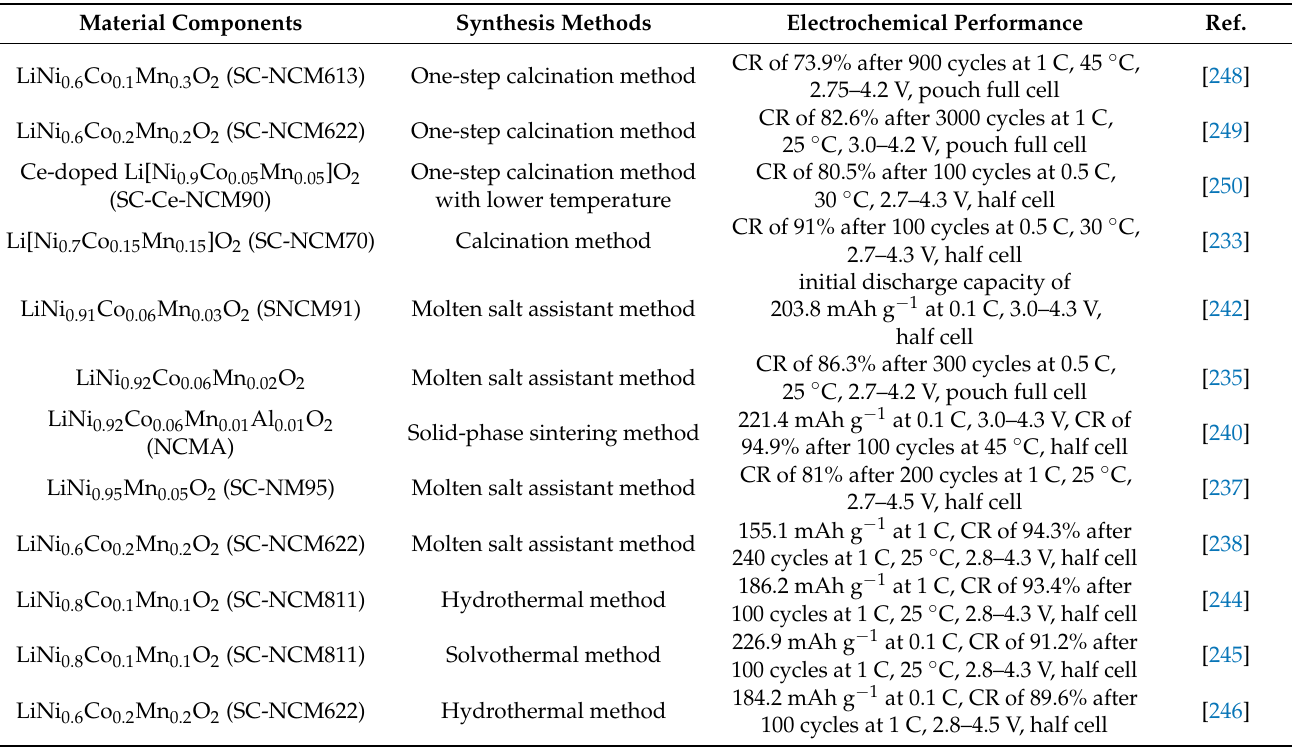
Table 1. Electrochemical properties of single-crystal nickel-rich NCM materials synthesized via different strategies. (CR = Capacity Retention). Material Components Synthesis Methods Electrochemical